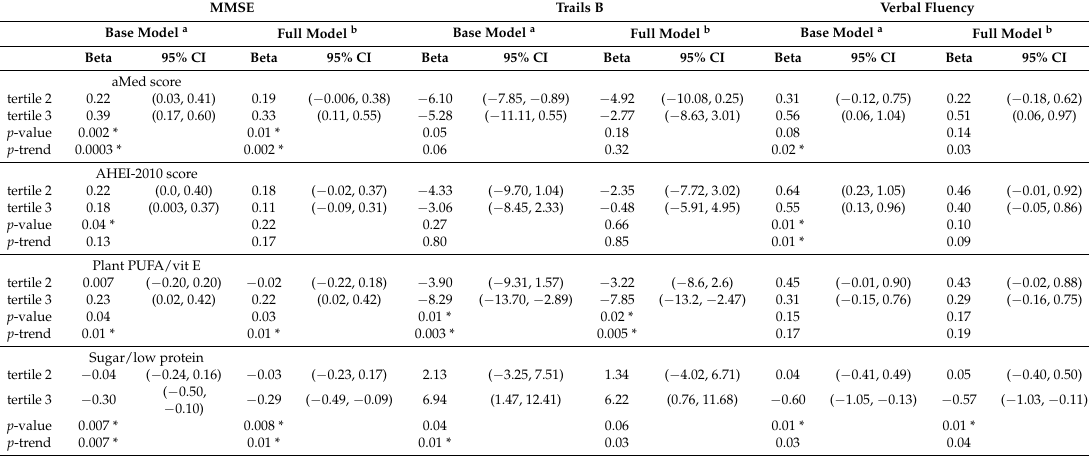
Table 3. Parameter estimates and 95% confidence intervals from the longitudinal mixed-effects analyses of tertile of dietary pattern with cognitive function, with the lowest tertile as the reference level. q -values < 0.05 are noted with a * next to the p